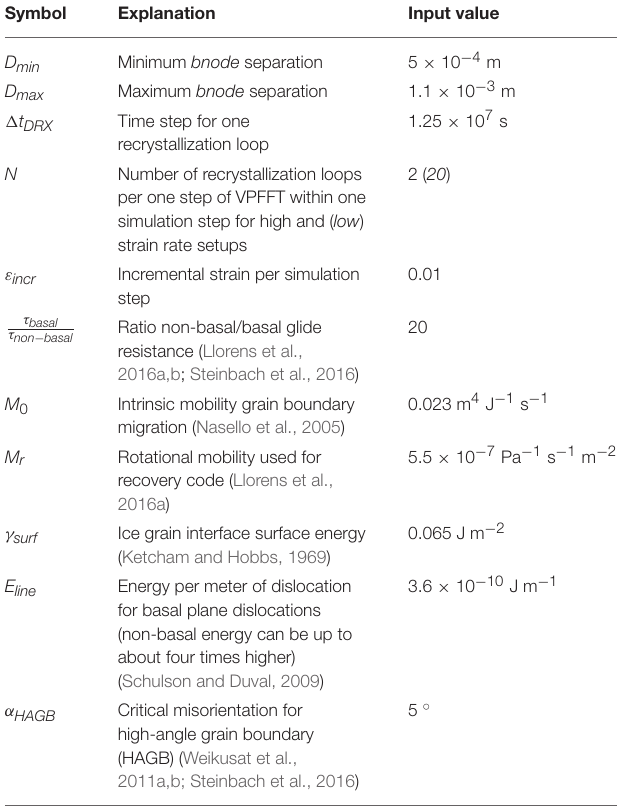
TABLE 1 | Overview of the settings of the numerical simulations. Simulation name